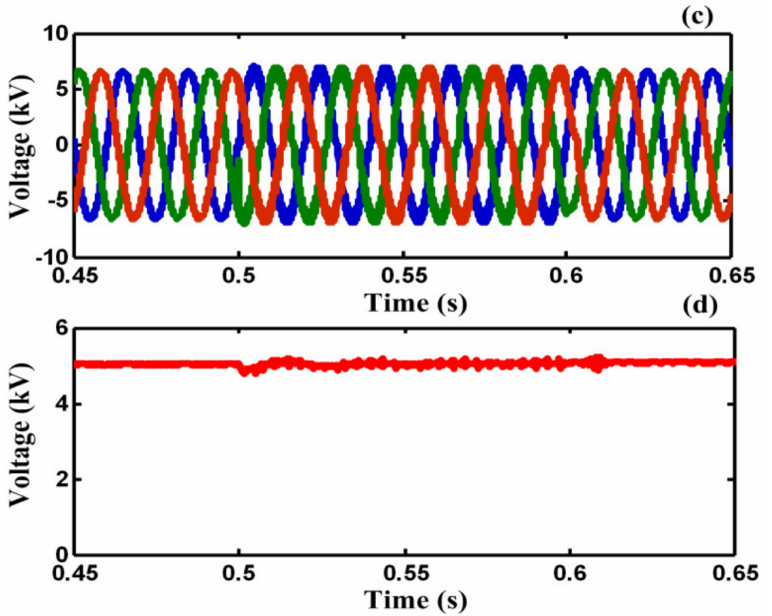
Figure 10. ( a ) load voltage, ( b ) DVR port injected voltage, ( c ) PCC voltage and, ( d ) capacitor voltage during fault, in case C.